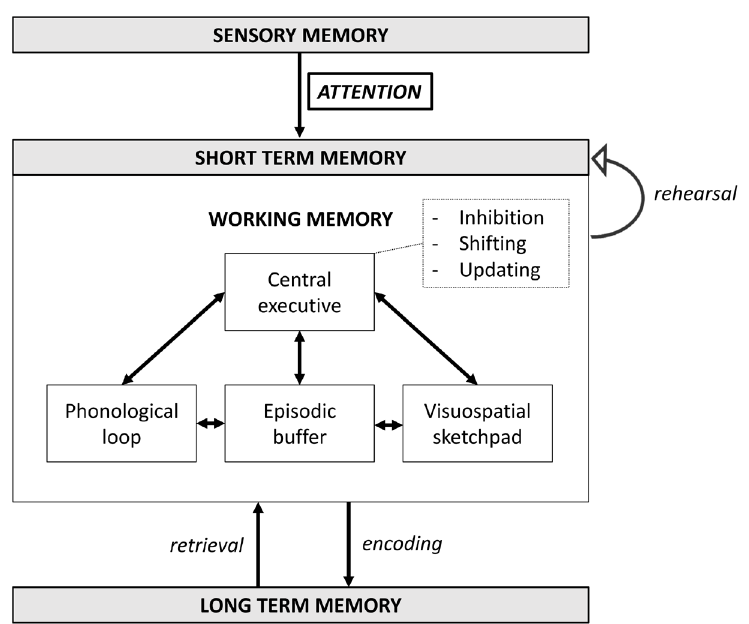
Figure 1. Memory model with the different components of the working memory and the interactions between the short-term and the long-term memory, based on (Baddeley,